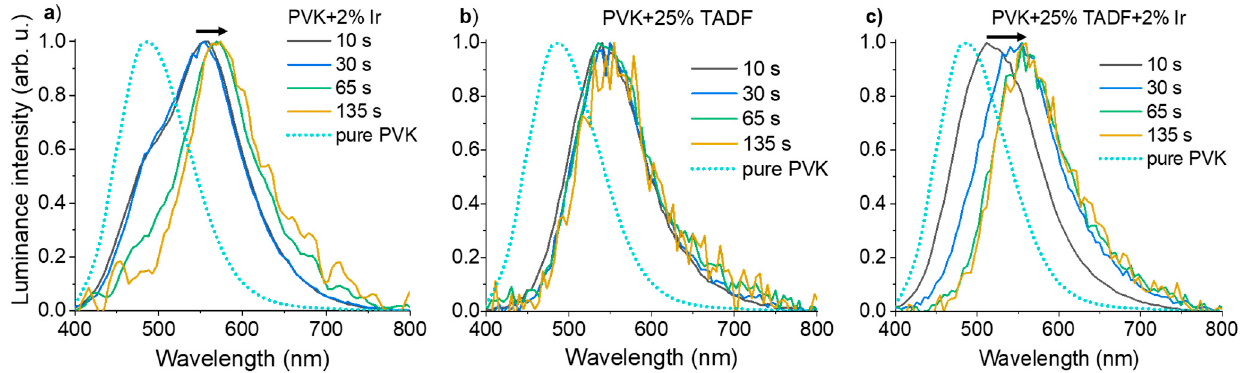
Figure 9. Spectra of isothermal luminescence decays registered in a long time scale at 20 K. Layers of: ( a ) PVK + 2 wt% Ir, ( b ) PVK+25 wt% SpiroAC–TRZ, ( c ) PVK+25 wt% SpiroAC–TRZ+2 wt% Ir.